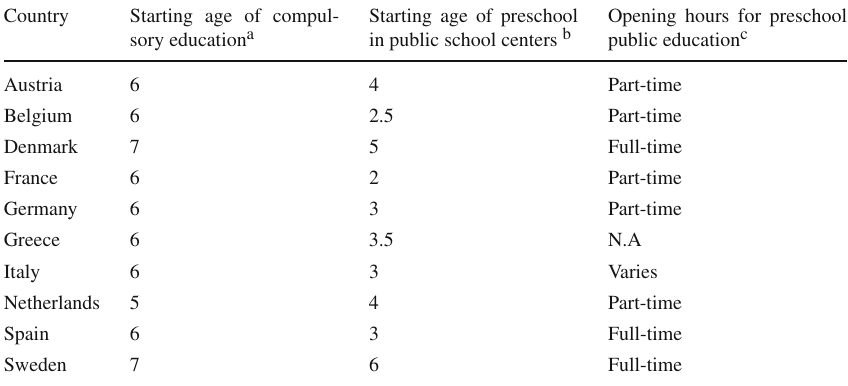
Table 3 Early childhood education